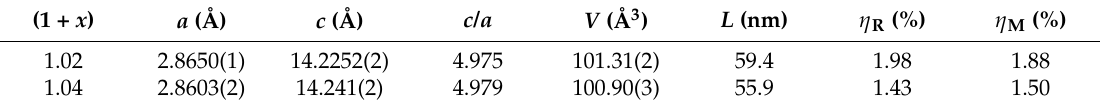
Table 3. Crystallographic parameter of Li 1+x (NMC) 1-x O 2 materials. η R and η M reveal the site-exchange rate of Ni 2+ (3 b ) cation mixing estimated from Rietveld refinements and magnetometry, respectively.